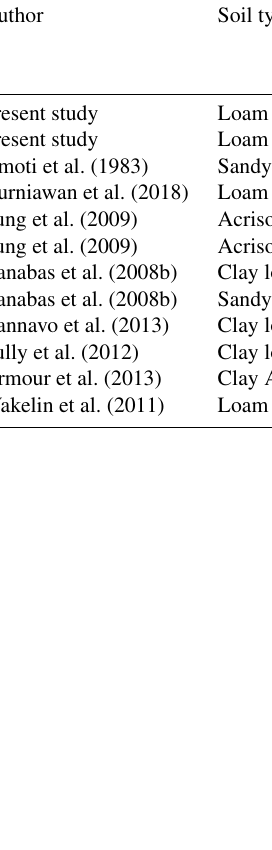
Figure A1. Lysimeter locations at each treatment plot with two subplots (blue rectangles) that each included the three management zones (blue crosses): (1) lysimeters in the palm circle were 1m from the palm stem, (2) in the frond-stacked area about 4m from the palm stem, and (3) in the inter-row approximately 4m from the palm stem.